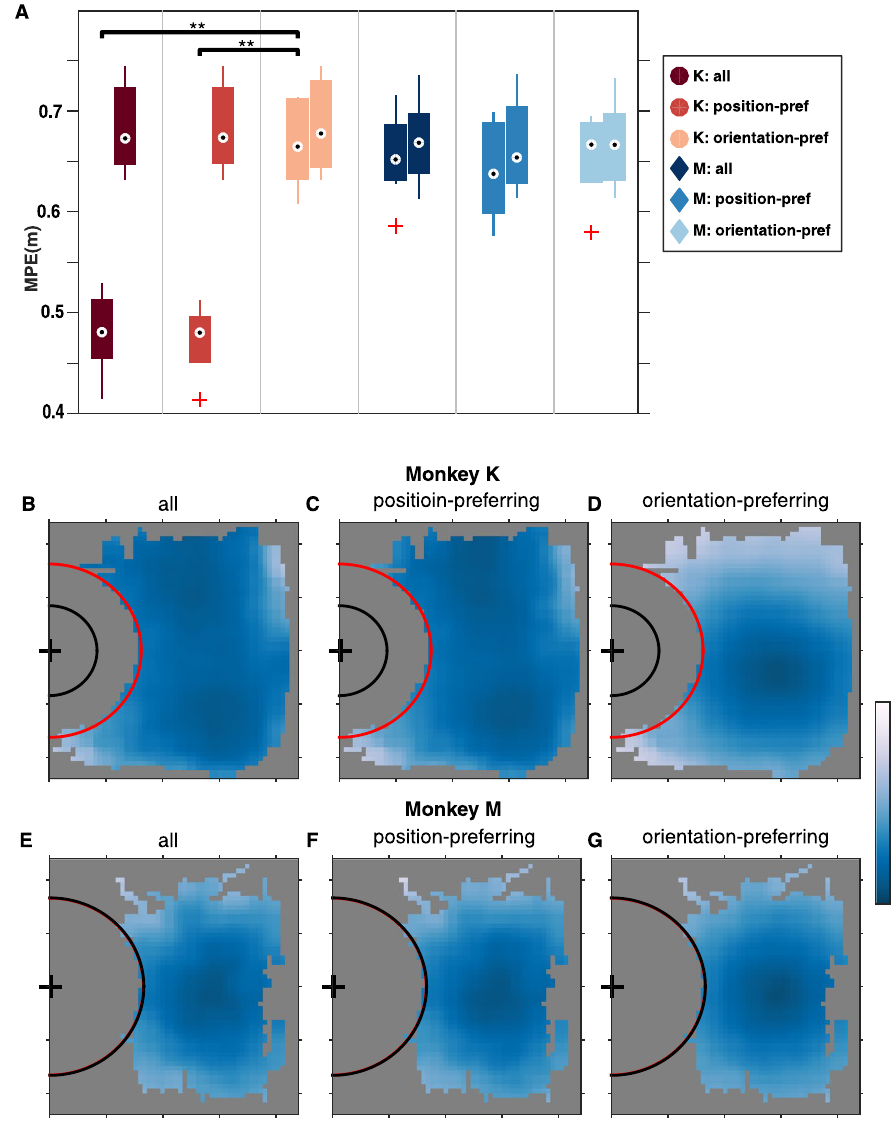
Figure 5. Decoding of room location from neuronal ensemble activity. ( A ) Box plots showing the distribution of decoding accuracy and chance decoding accuracy (left and right boxes within each group, respectively) measured by the mean prediction error (MPE) in meters, in monkey K and monkey M using different population of neurons. Only sessions with decoding accuracy significantly above chance are shown. The distributions of chance-level decoding accuracy are constructed from the lower-end of the 95% confidence interval of the selected sessions’ chance-level error. ( ** ) indicates significant p-value < 0.01 for post-hoc Tukey’s multiple comparison following Kruskal-Wallis test. (B–G) Color plots of MPE as a function of room location in one representative session each for monkey K ( B–D ) and monkey M ( E–G ) – from using all neurons ( B , E ), position-preferring neurons ( C , F ), and orientation-preferring neurons ( D , G